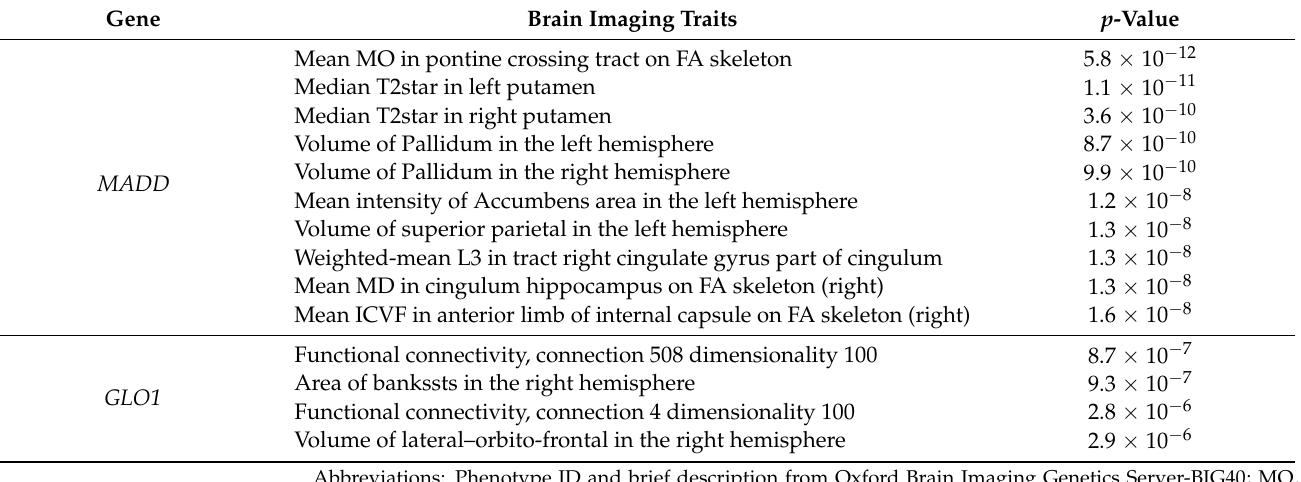
Table 4. Brain imaging traits related to MADD and GLO1 genes. Gene Brain Imaging Traits p -Value Mean MO in pontine crossing tract on FA